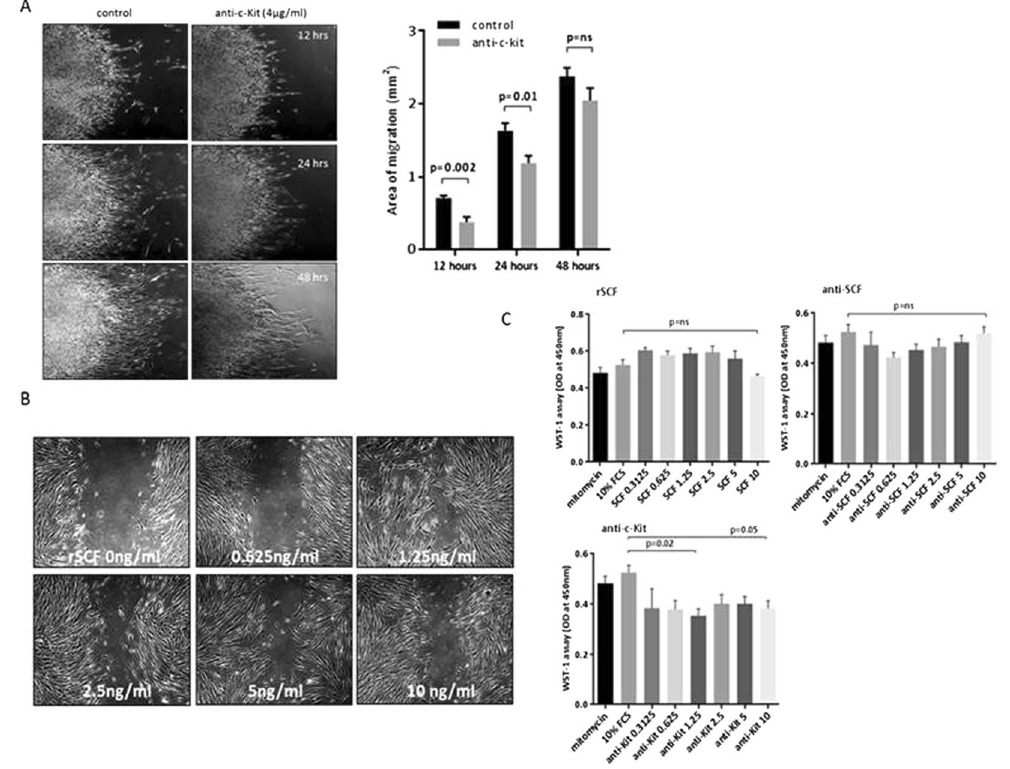
Figure 3. Role of SCF/c-Kit in regulating lung fibroblast migration and proliferation. 4 control lung fibroblast lines were applied to aligned collagen as cellular foci, and then stimulated to migrate using FCS 10%, with or without the addition of polyclonal anti c-Kit (4 µ g/ml), and imaged at 12, 24 and 48 hours. After 12 hours the cell migration was significantly reduced (p = 0.002) in treated cells. Similarly, after 24 hours anti c-Kit decrease cell migration (p = 0.01) but there was no significant difference after 48 hours ( A ). Further experiments were performed with standard scratch migration assays. Here additional recombinant SCF (rSCF) enhanced scratch migration in control lung fibroblasts already stimulated by the presence of serum in the media. Maximal migration was observed when using 1.25 ng/ml of rSCF (p < 0.05 vs unstimulated cells) ( B ). Possible effects of the SCF/c-Kit axis on control lung fibroblast proliferation were investigated by adding rSCF as agonist or by blocking SCF/c-Kit with neutralising polyclonal anti-SCF or ant-c-Kit. The addition of rSCF (0–10 ng/ml) at the start of a 24 hour proliferation assay led to a non-significant increase in cell number, whereas addition of anti- SCF was associated with a trend to reduced cell number. Again not statistically significant. However